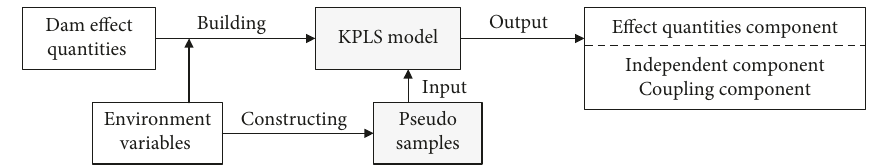
Figure 4: Entire flow of the nonlinear method for component separation of dam effect